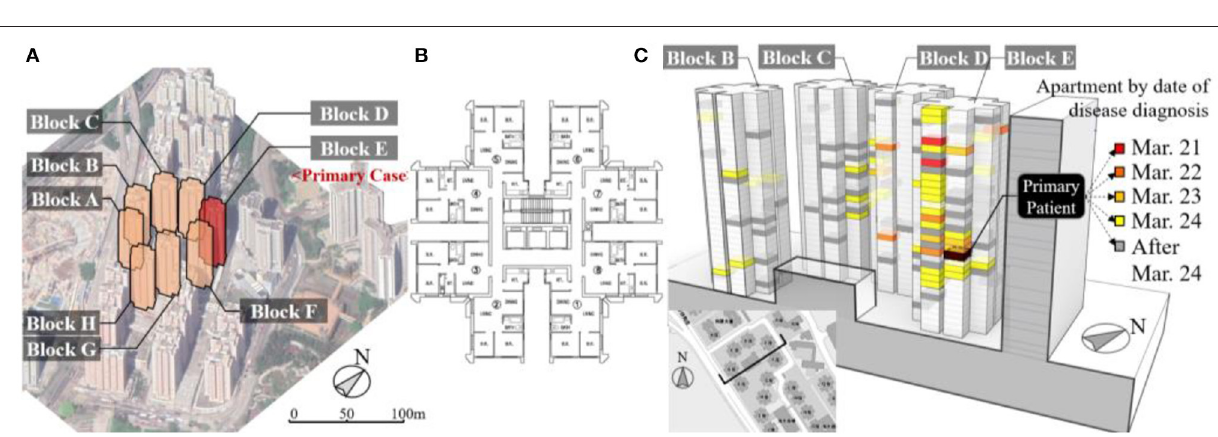
FIGURE 3 | (A) Configuration of the Amoy Gardens Phase I during the 2003 SARS outbreak; (B) a typical building floor plan for Amoy Gardens (SARS Expert Committee, 2003); and (C) a summary of SARS infection cases by date of symptom onset in Amoy Gardens, Hong